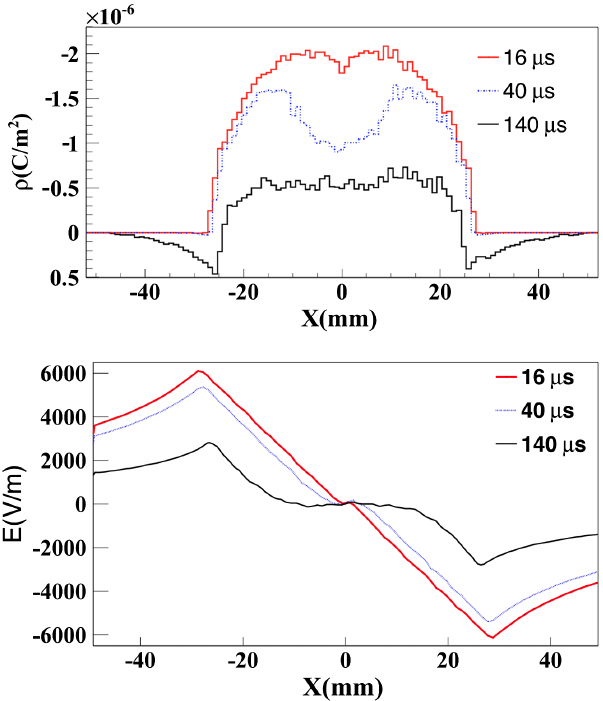
mbar.FIG. 8. Evolution in the time of space charge density (beam and secondary ions) and electric field. SCC τ ¼ 90 μ